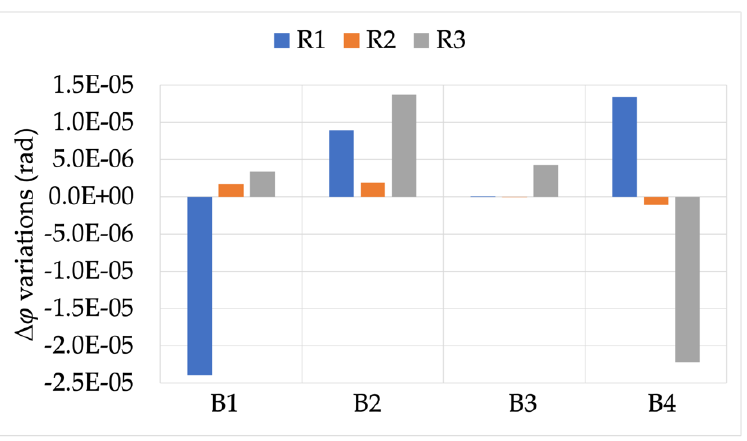
Figure 4. ∆𝜑 variations, when measuring signal X, for burdens B1 to B4.